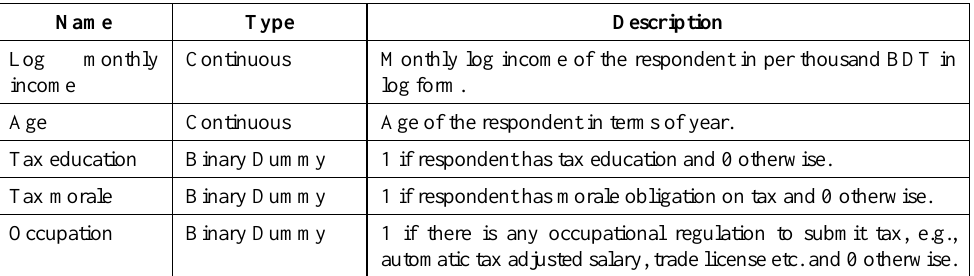
Table 1. The independent variables of the